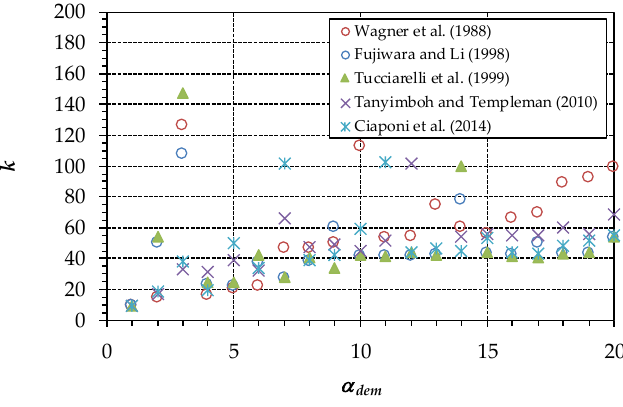
Figure 8. Second case study. Number k of iterations as a function of α dem for the various